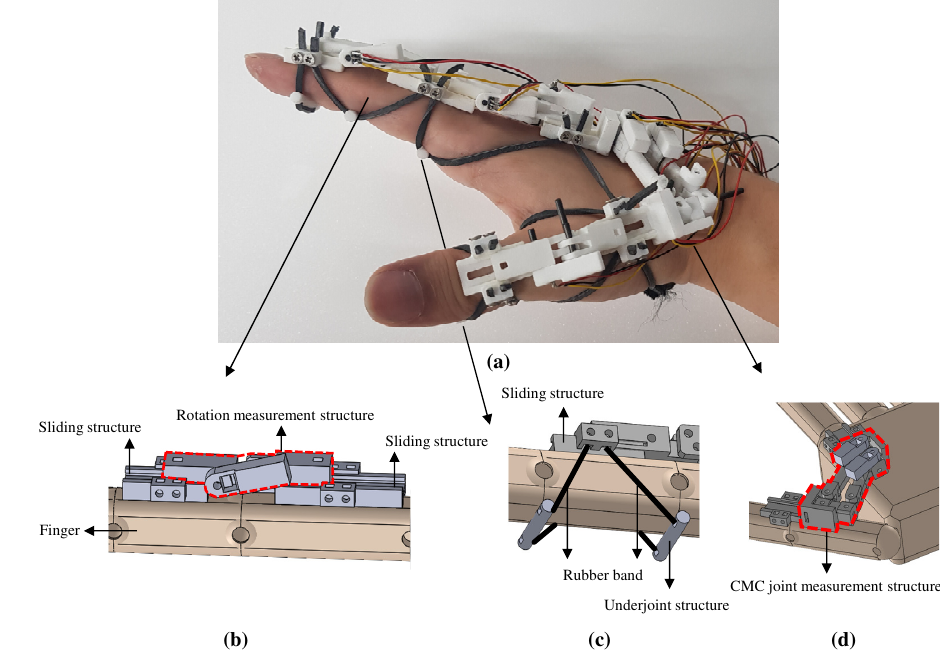
Figure 2. System design of the proposed device; ( a ) Prototype; ( b ) Rotation measurement structure; ( c ) Underjoint structure and wearing method; ( d ) Structure design of carpometacarpal (CMC)